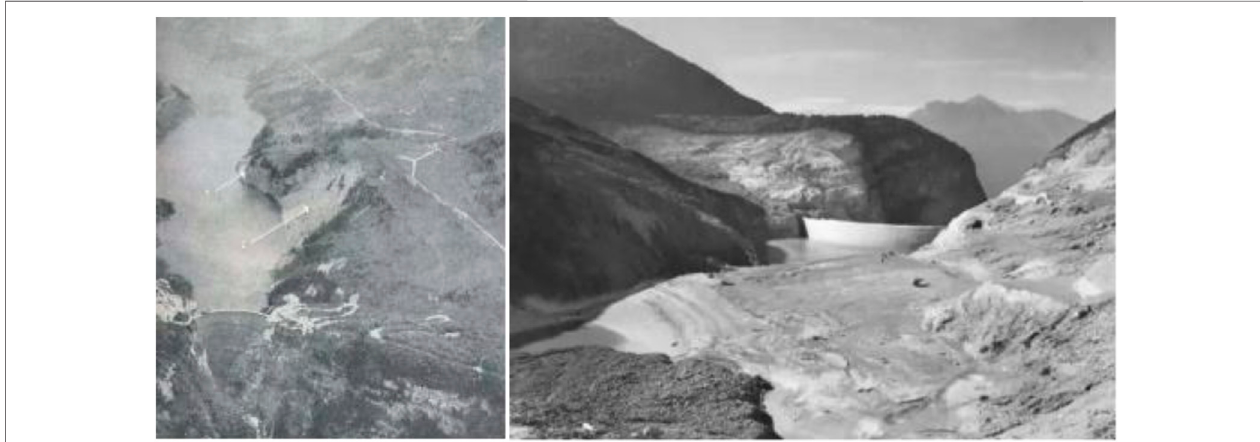
FIGURE 1 | Vajont dam ’ s left bank slope